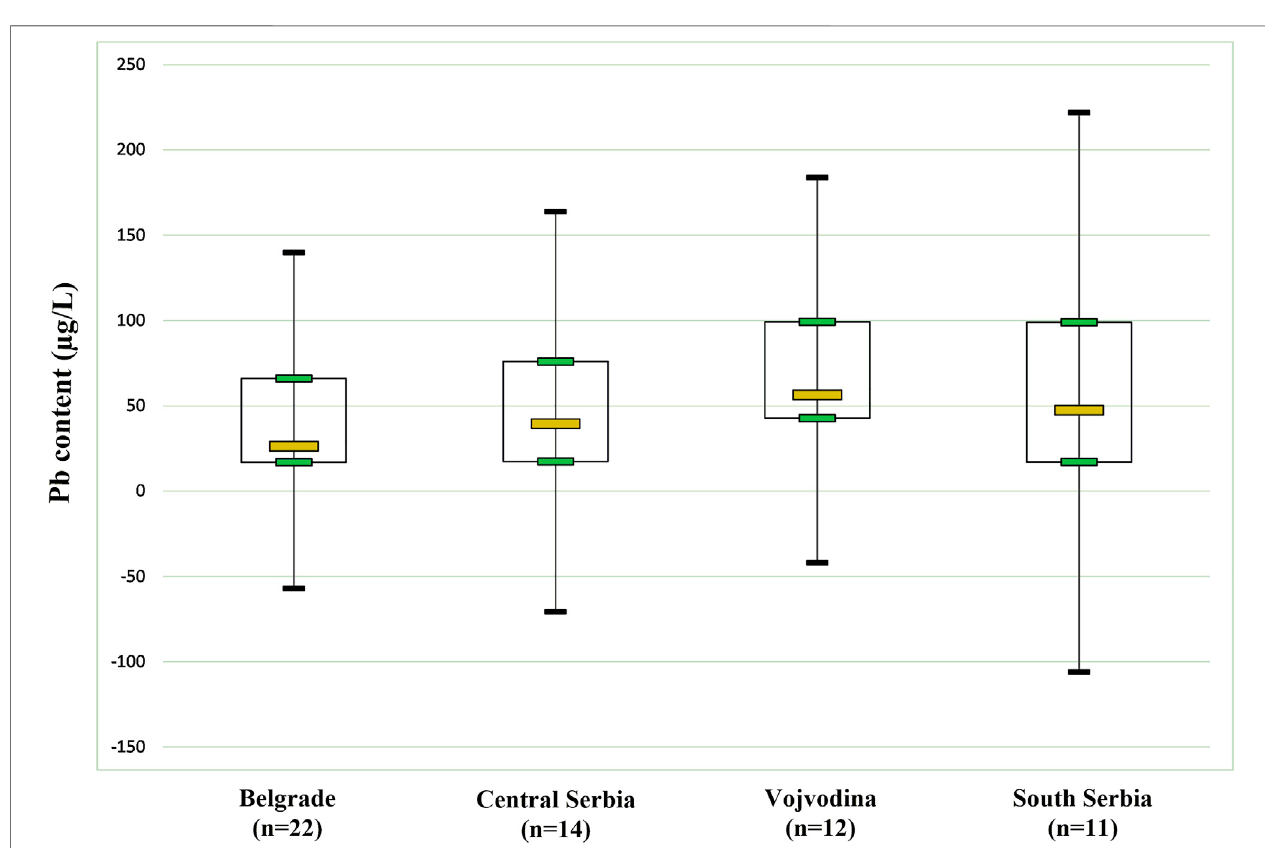
FIGURE 2 | Box and whisker plot of Pb content determined in studied wine samples from different regions of Serbia. Legend: n -number of samples.